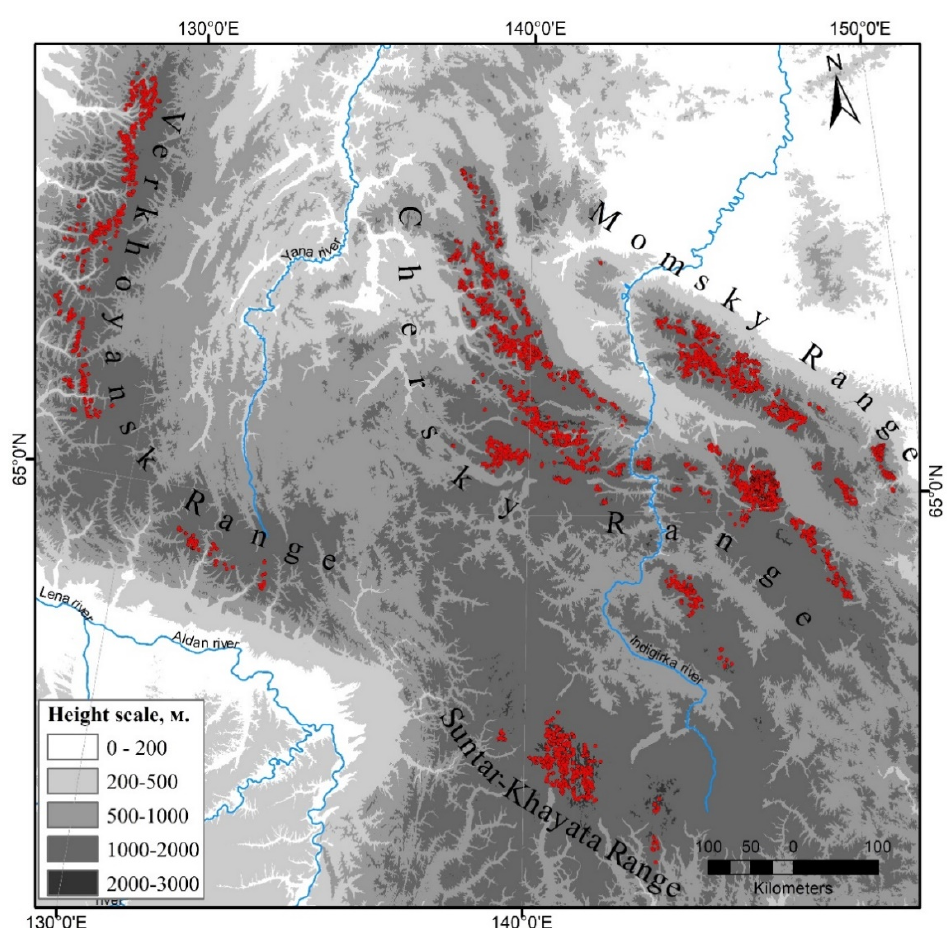
Figure 3. Distribution of rock glaciers in the study area. Mapped rock glaciers are indicated with red circles. Table 2. Statistics of Rock Glaciers of the Suntar-Khayata